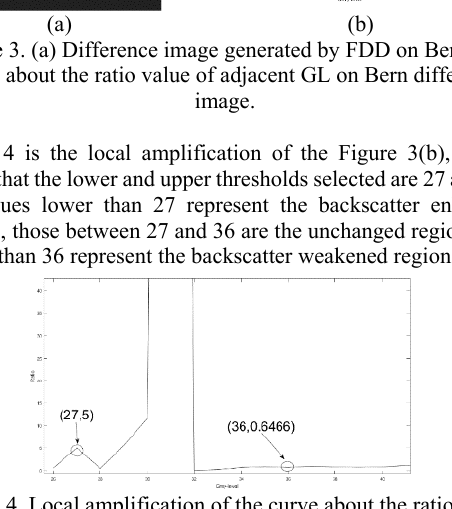
Figure 4. Local amplification of the curve about the ratio value of adjacent GL on Bern difference